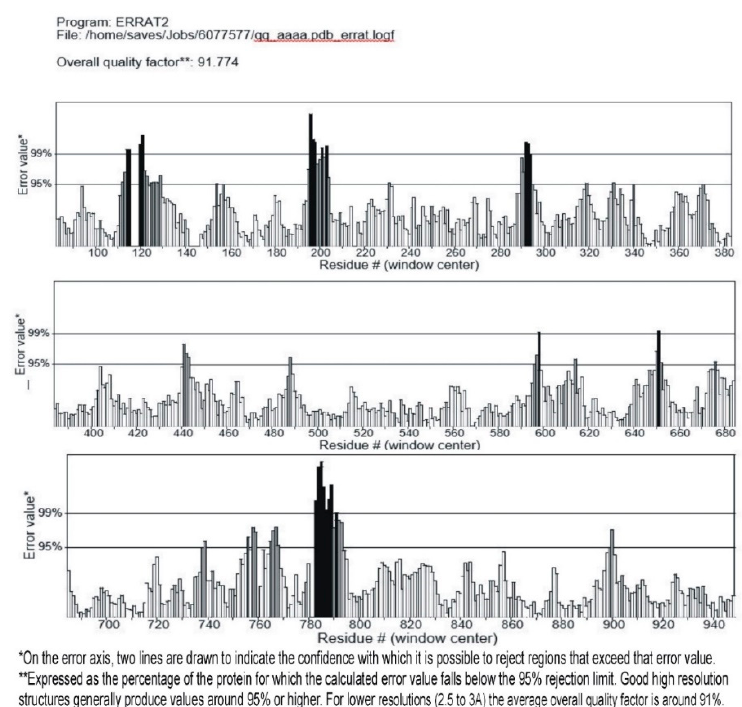
For protein structure verification,